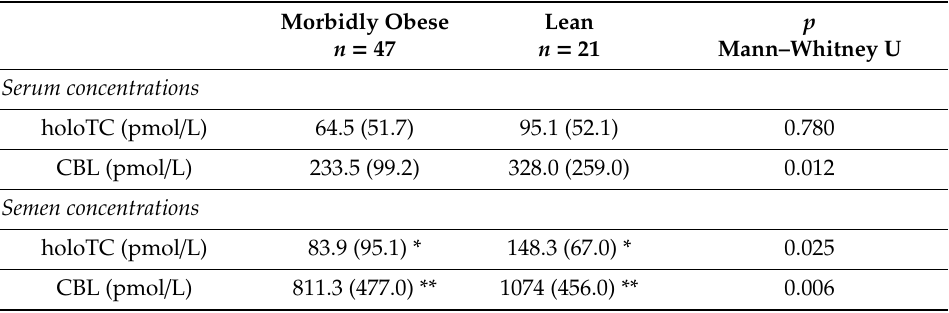
Table 2. CBL and holoTC concentrations in serum and semen: HoloTC and CBL concentrations are reported for morbidly obese and lean subjects as median (IQR) for not-normally distributed parameters and the Mann–Whitney U test was applied for comparison between obese and lean subjects. Statistical significance between seminal and circulating concentrations of holoTC and CBL: Significant p values are indicated in italics for comparison between morbidly obese and lean subjects.